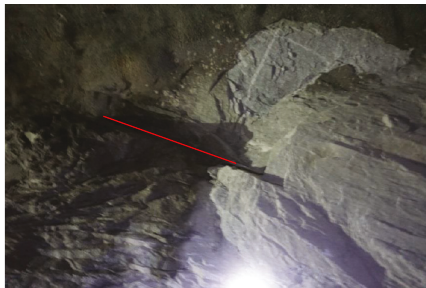
Figure 28: Wedge cavity of arch shoulder in K0 +540m of the tailrace surge chamber pilot hole